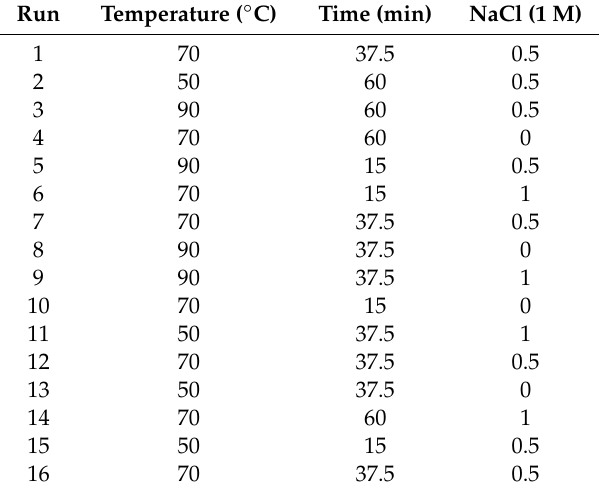
Table 2. Box-Benkhen experimental design proposed for the headspace solid-phase microextraction (HS-SPME) optimization